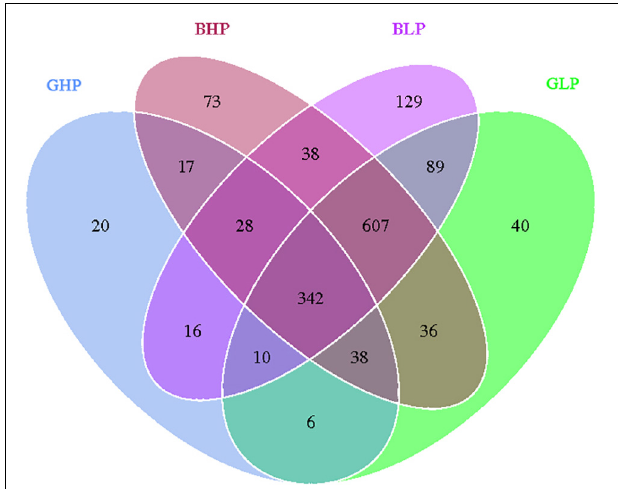
FIGURE 1 | Venn diagram showing the unique and shared OTUs in the different groups. GHP, gilts fed high protein diet; BHP, barrows fed high protein diet; GLP, gilts fed low protein diet; BLP, barrows fed low protein